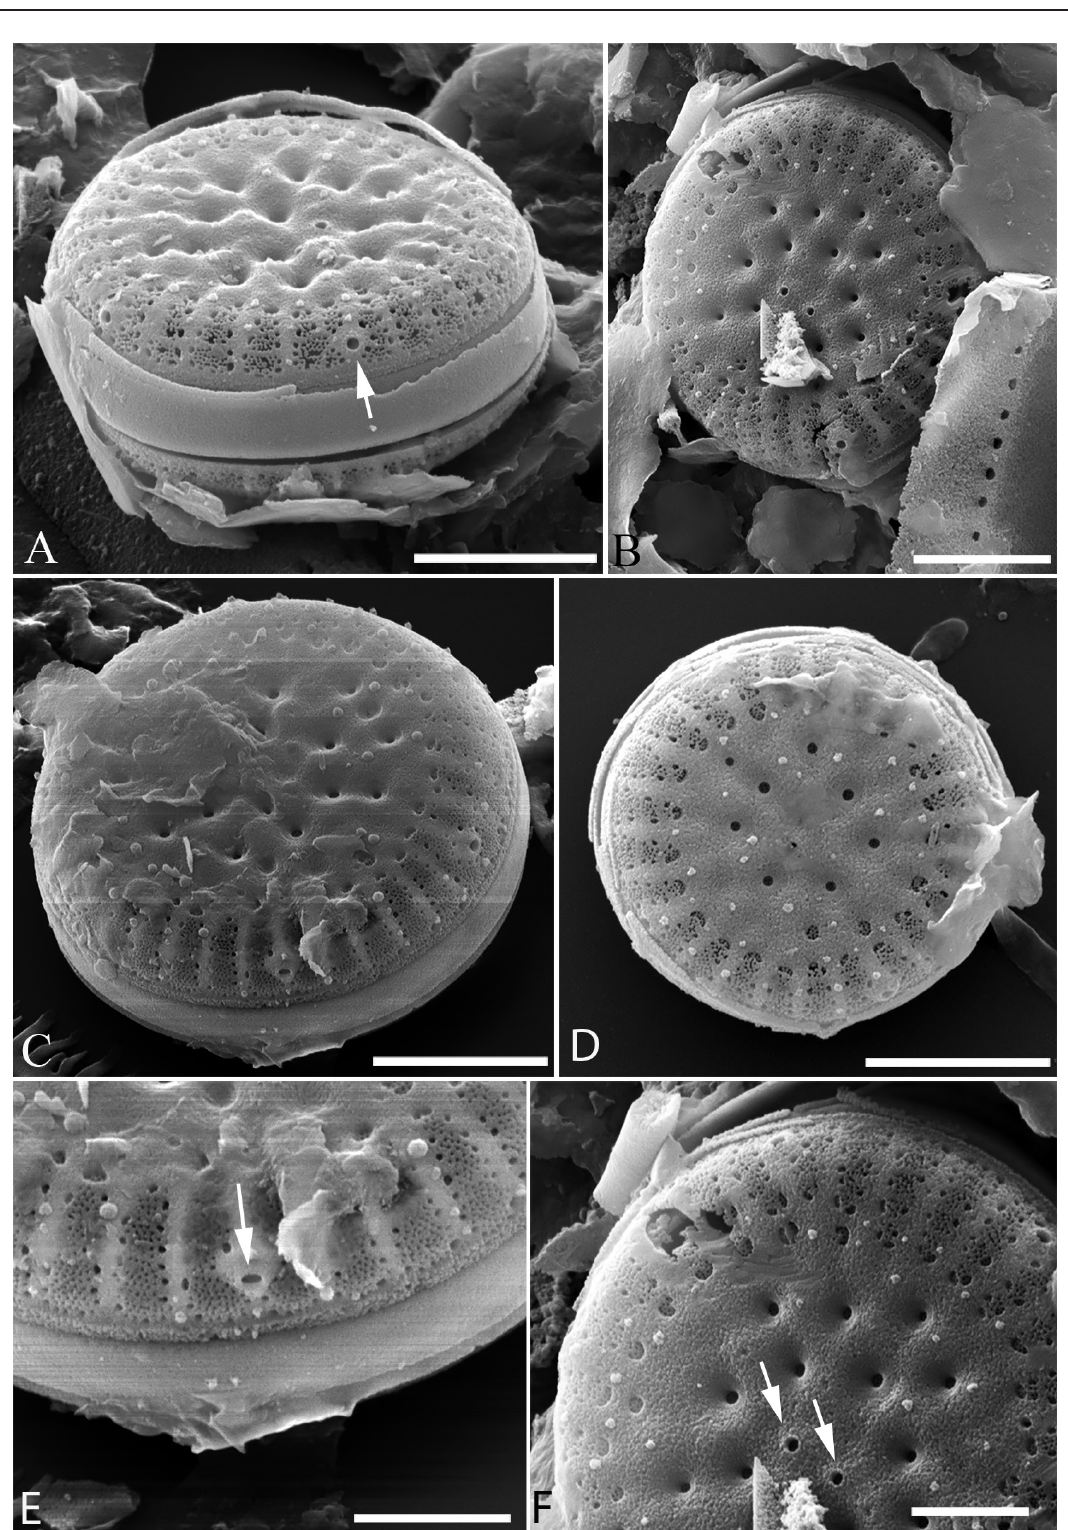
Fig. 2. Tertiarius minutulus sp. nov., SEM external valve views. A . Valve view showing the marginal openings of the fultoportulae (see white arrow). B – D . View of the whole frustule. E . Close view of marginal openings of the fultoportula (see white arrow). F . Close view of the external openings of the valve face fultoportulae (see white arrows). Scale bars: A–D = 2.0 µm; E–F = 1.0